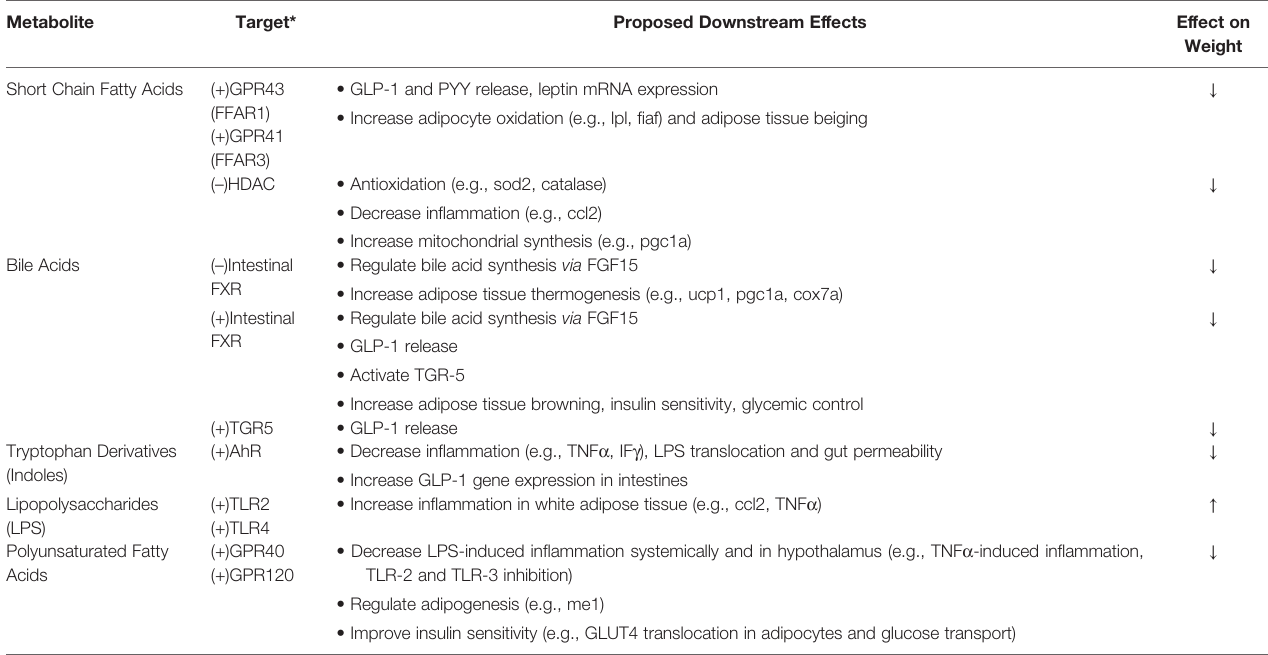
TABLE 1 | Summary table of mechanisms and downstream effects of each metabolite.